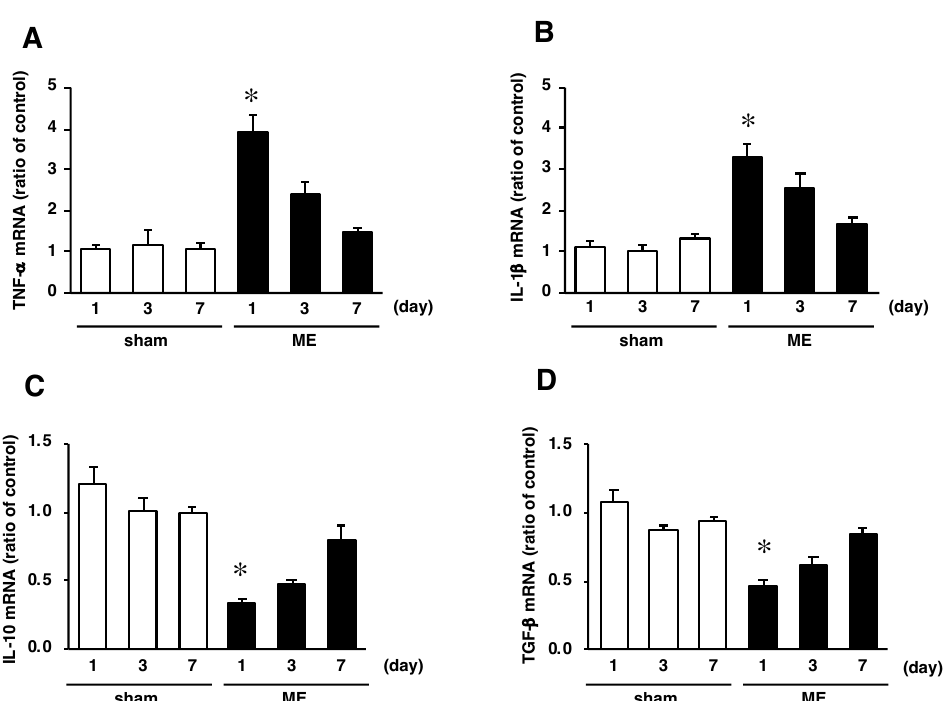
Figure 4. Time course of changes in the mRNA levels of TNF- α ( A ), IL-1 β ( B ), IL-10 ( C ), and TGF- β ( D ) in the sham-operated (sham; white bars) and ME-operated groups (ME; black bars) on days 1, 3, and 7 after surgery. Results are expressed as the mean ratio of the non-operated (control) group ± SD ( n = 6 independent experiments). * Significant difference from the sham-operated group ( p < 0.05).